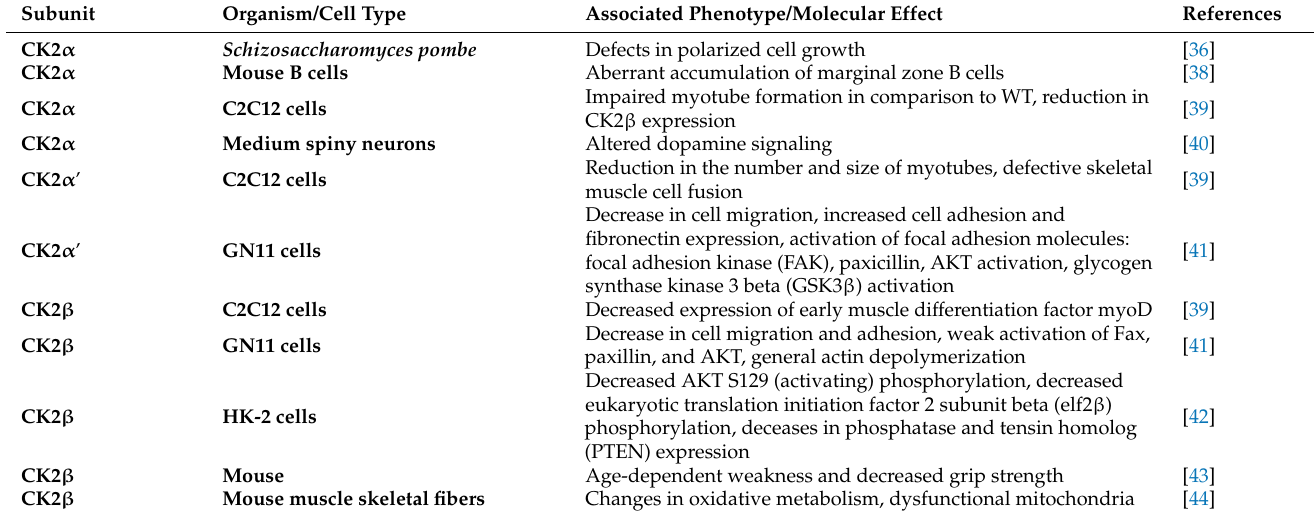
Table 1. Phenotypes associated with CK2-specific subunit knockouts.